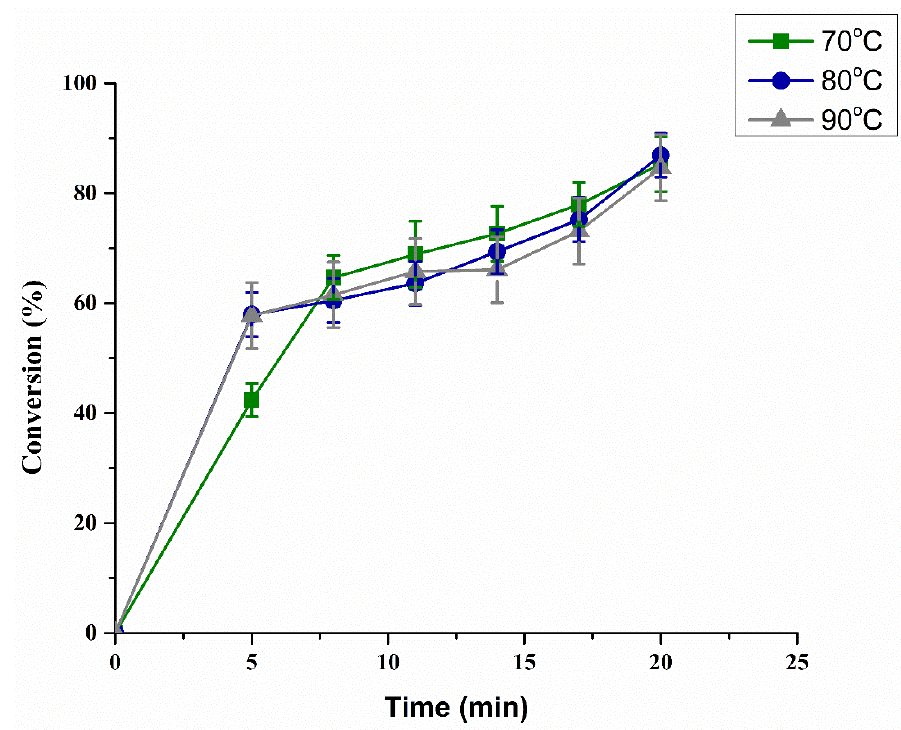
Figure 5. Effect of different temperatures on WCO conversion into biodiesel.